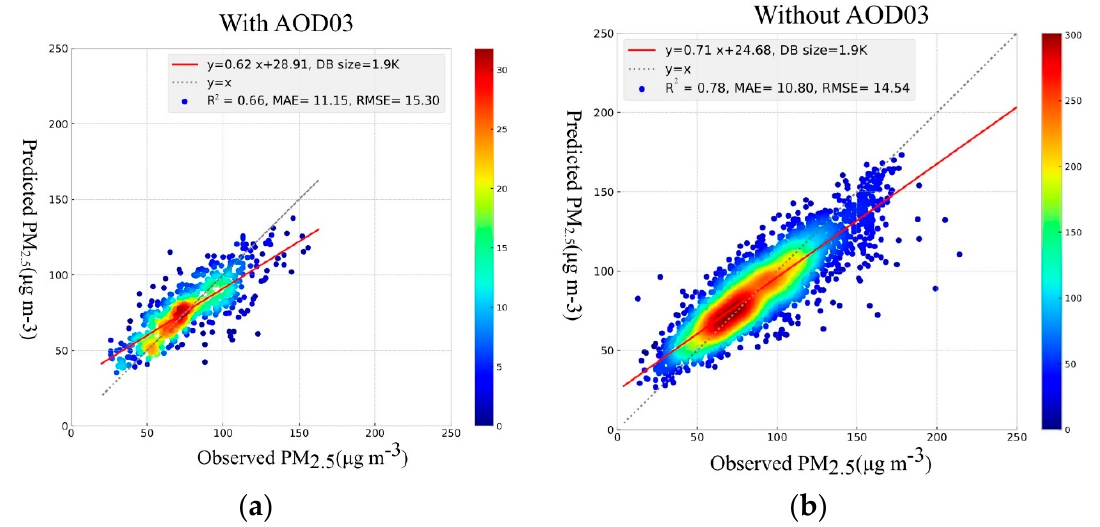
Figure 3. Scatter plot of predicted PM 2.5 versus observed values using the RF method. The total dataset record was 41.2 k, with 1900 (including AOD03) and 11800 (excluding AOD03) non-missing records available and used for training the model. ( a ) Scatter plot of predicted vs. observed PM 2.5 including AOD03. ( b ) Scatter plot of predicted vs. observed PM 2.5 excluding the AOD03 variable. The line in red shows a linear regression between observed and predicted PM 2.5 values for the test dataset.